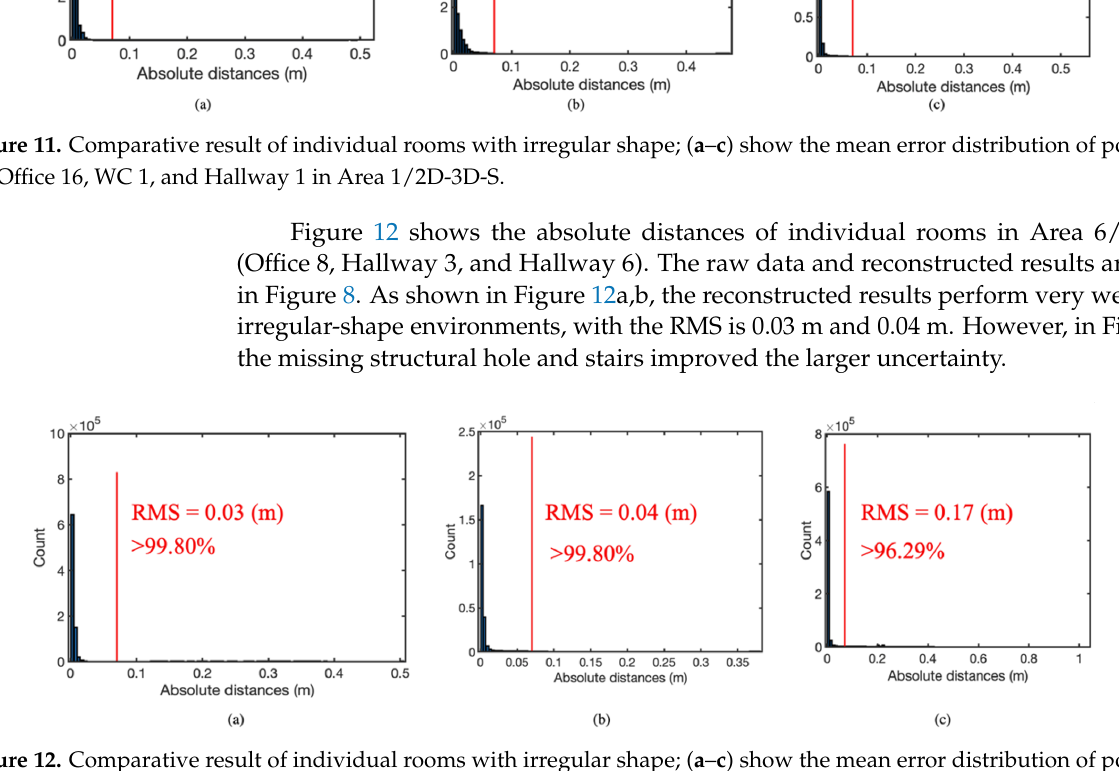
Figure 12. Comparative result of individual rooms with irregular shape; ( a – c ) show the mean error distribution of points for Office 8, Hallway 3, and Hallway 6 in Area